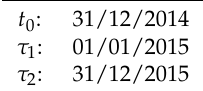
Table 4. Quanto option measurement